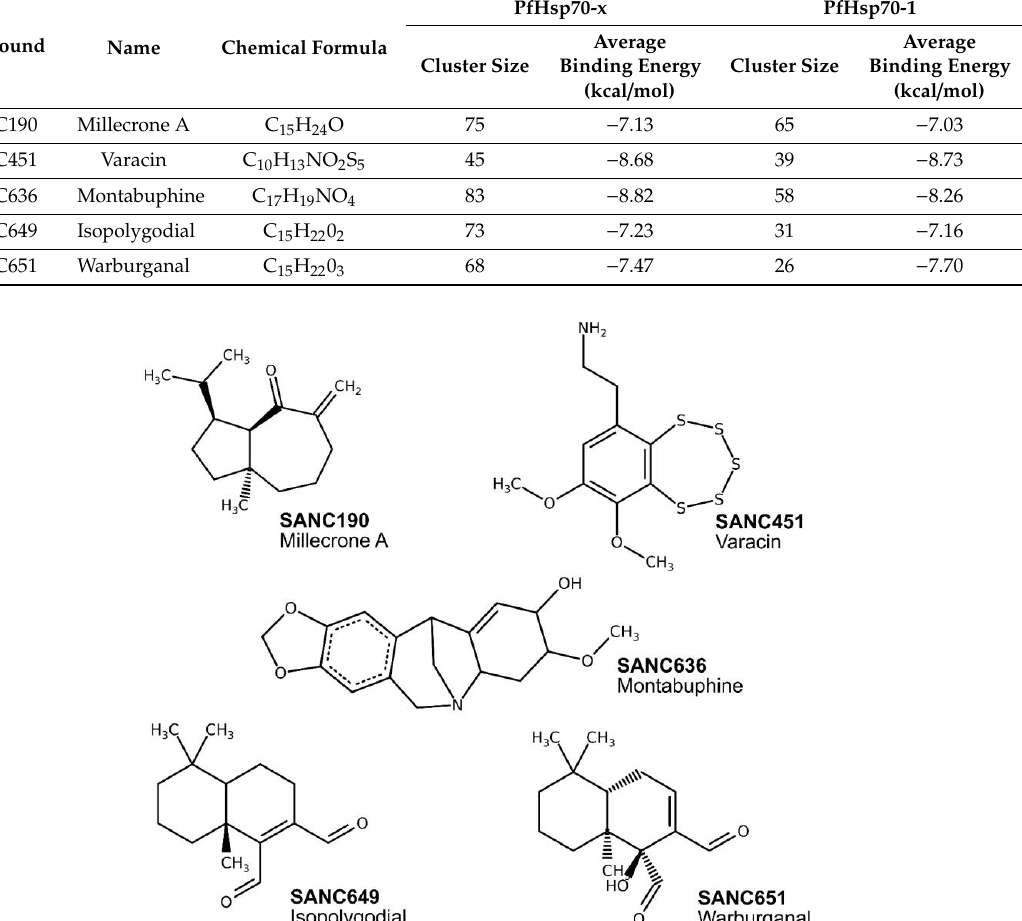
Figure 2. Chemical structures of identified natural compounds docked to the β-SBD back pocket in both PfHsp70-x and both PfHsp70-x and PfHsp70-1.